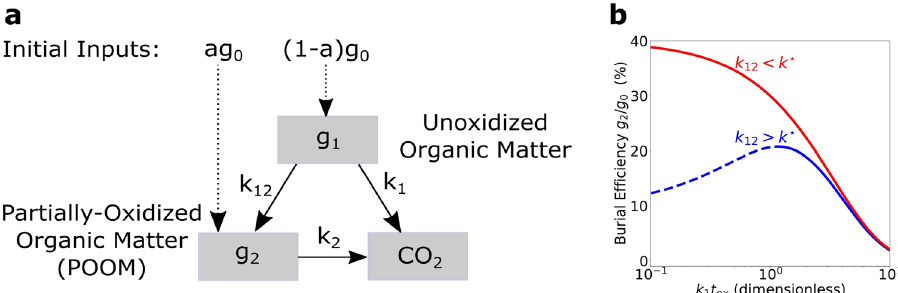
Fig. 2 A theoretical prediction of a positive feedback responsible for Earth ’ s oxygenation. a Degradation paths of unoxidized organic matter and partially oxidized organic matter (POOM). The quantities g 1 and g 2 represent the amount of unoxidized organic matter and the amount of (physically protected) POOM deposited in sediments, respectively. Unoxidized organic matter is either directly oxidized to CO 2 with a rate constant k 1 or transformed to POOM with a rate constant k 12 . POOM is oxidized to CO 2 with a rate constant k 2 . b Burial ef fi ciency g 2 / g 0 as a function of dimensionless oxygen-exposure time k 1 t ox . Positive feedback occurs when burial ef fi ciency increases with oxygen-exposure time (blue dashed curve), which requires k 12 > k ⋆ [Eq.